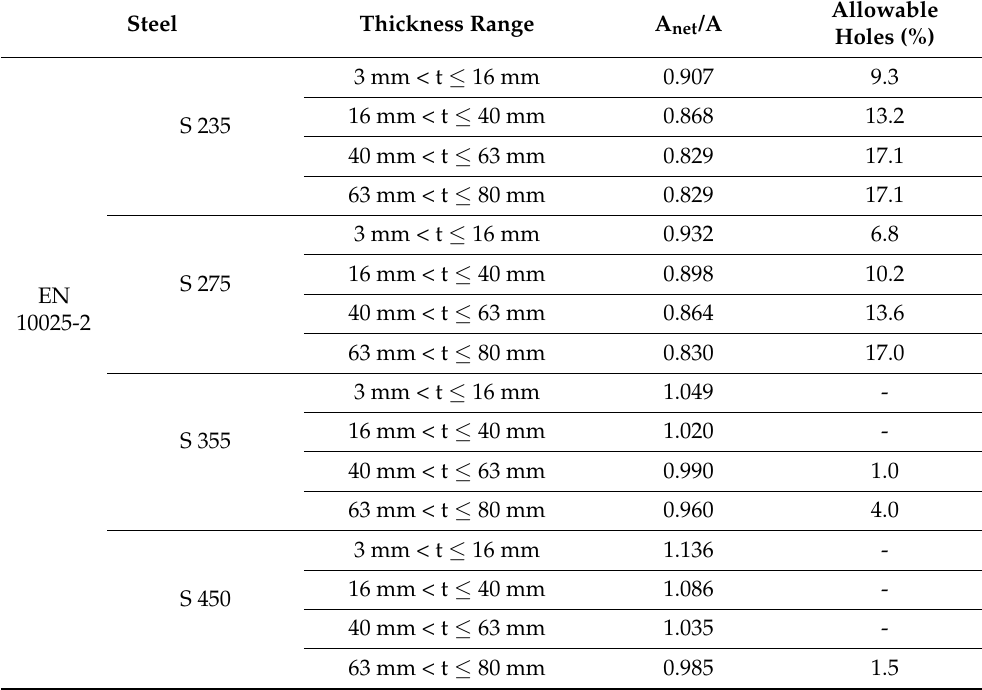
Table 4. Allowable net/gross area ratio for bolted steel connections under the Eurocode 8 framework, considering EN10025-2 steel